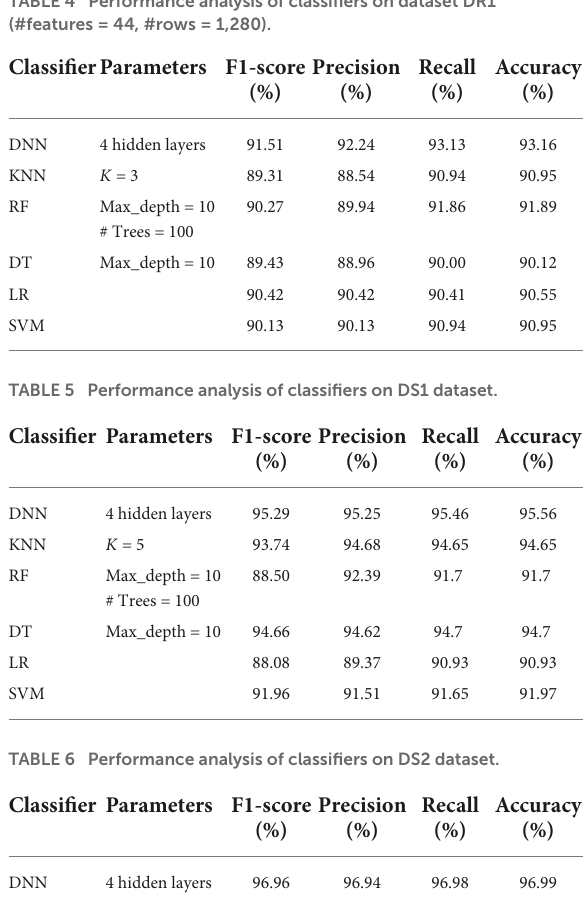
TABLE 4 Performance analysis of classifiers on dataset DR1 (#features = 44, #rows = 1,280).